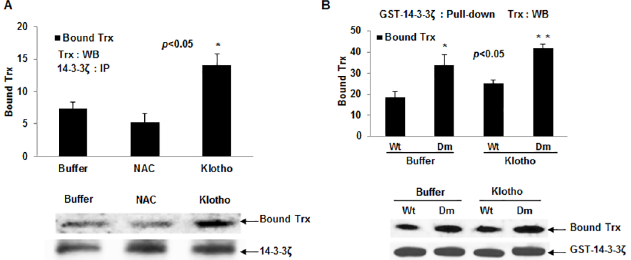
Fig 3. Mitigating effect of soluble Klotho on endogenous 14-3-3 ζ and Trx complex formation. (A) Levels of Trx bound to endogenous 14-3-3 ζ in HEK 293 cells treated with either secreted Klotho, or NAC, or buffer control for 40 min as described in text. * p < 0.05 between control buffer and Klotho treated samples. The Western blot profile is shown beneath. (B) Levels of Trx bound to GST-14-3-3 ζ wild type (Wt) and dimerization deficient mutant (Dm). Samples were treated with either buffer only or secreted Klotho for 40 min. * p < 0.05 between Wt and Dm. Shown beneath is a corresponding representative Western blot. Digitized values of the WB are shown in S4